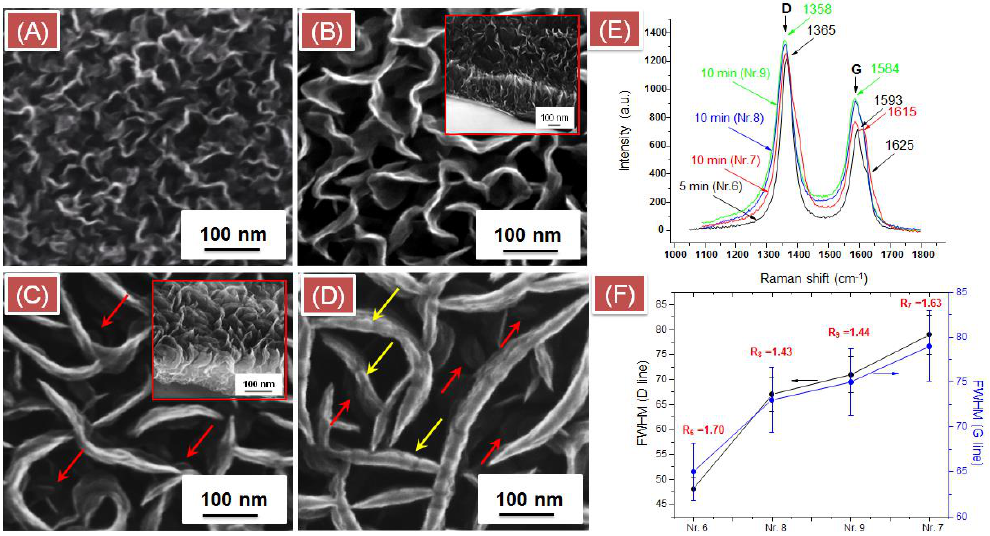
Figure 3. ( A – D ) Representative FE-SEM images of a VOG coating prepared by the ICP CVD roll-to-roll method at technological parameters corresponding to Samples 6–9. ( E ) Averaged Raman spectra of these VOG coatings (473 nm excitation wavelength, 100 × objective, 10 s of integration time). Color coding represents the samples by numbering. ( F ) Full width at half maximum (FWHM) values of the D and G lines calculated from the averaged Raman spectra. The “R” (in red color) represents the calculated IntD/IntG (peak height) ratio.